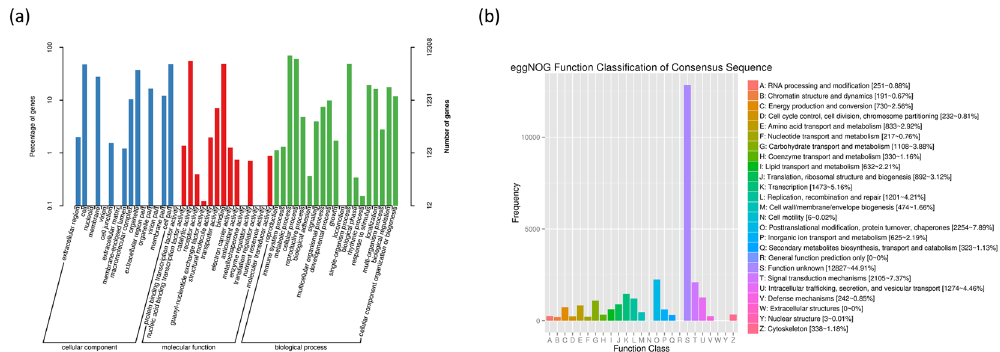
Figure 5. GO functional annotation and eggNOG annotation of Zostera japonica transcripts. ( a ) GO annotation, where blue represents cellular component, red represents molecular function, and green represents biological process. The x-axis represents GO categories, the y-axis (left) represents the percentage of genes, and the y-axis (right) represents the number of genes. (b) eggNOG annotations, where the x-axis represents eggNOG categories and the y-axis represents the number of